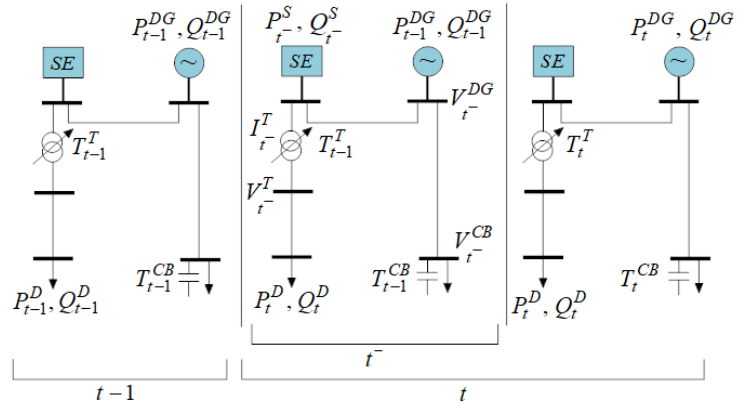
Figure 5. Graphical representation of the steps used to create the